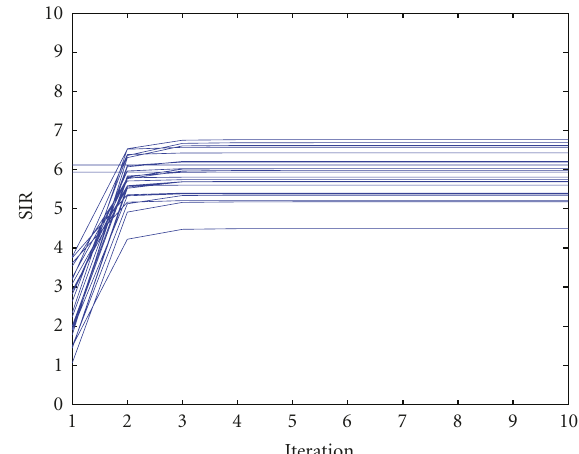
Figure 13: Uplink individual user SIR convergence for Gaussian = 0 . 01, γ = 5 . channel estimation error σ 2 h